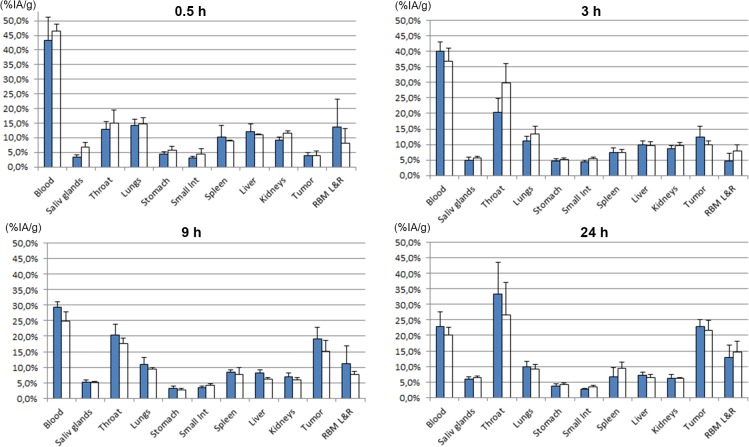
Tissue distribution of 125I-MX35 and 125I-Rebmab200.
125I-MX35 (filled bars) and 125I-Rebmab200 (open bars).Results are given as mean ± standard deviation of percent injected activity per gram tissue (%-IA/g). Abbreviation RBM L&R is the red bone marrow taken from left and right femur.